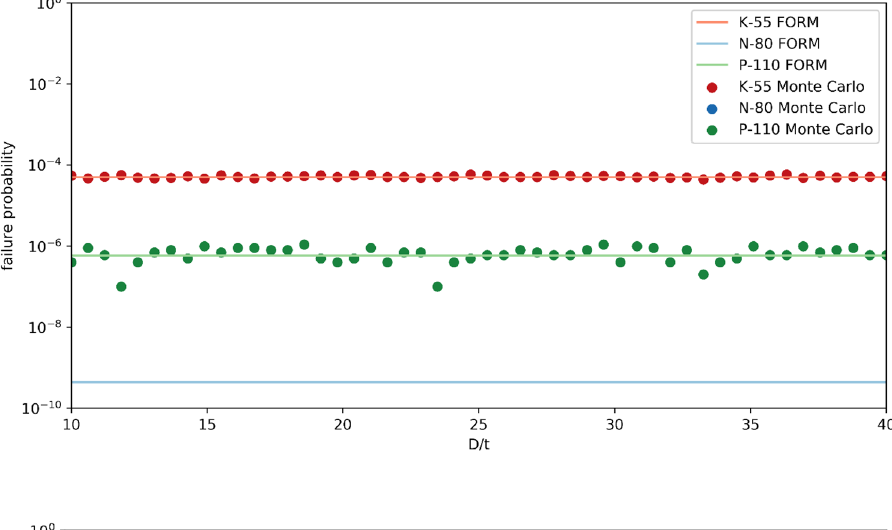
Fig. 6 Axial failure probabili- ties over D/t